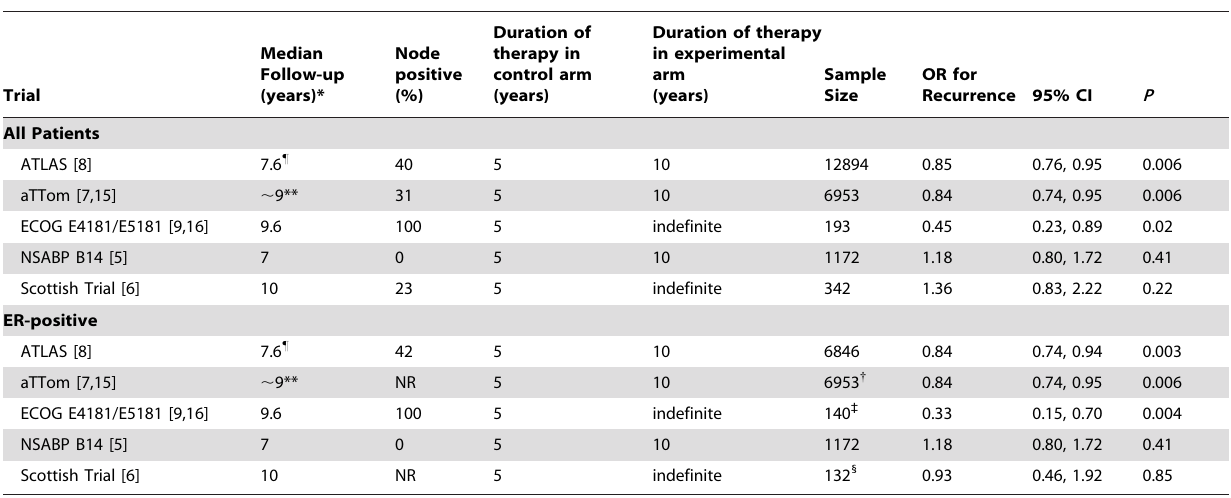
Table 1. Characteristics of Included Studies.